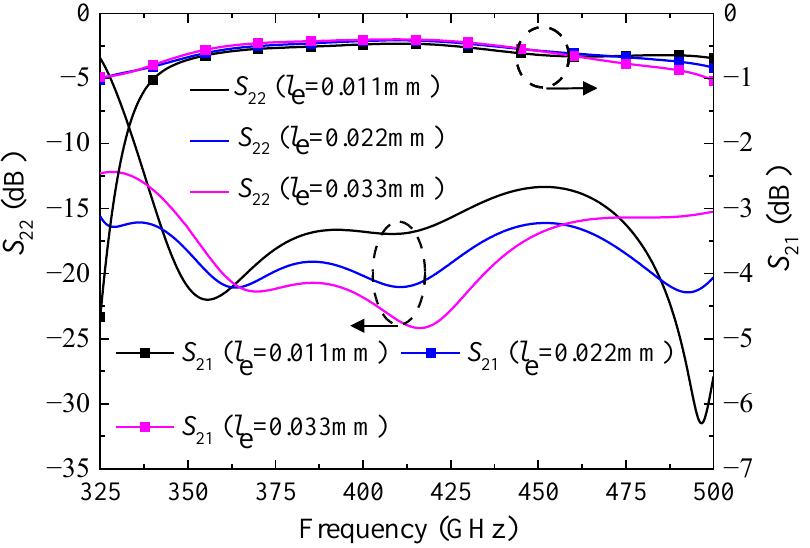
Figure 8. Simulated S -parameters of the proposed transition with different l e (Solid lines represent S 22 ; lines with square symbols represent S 21 ).